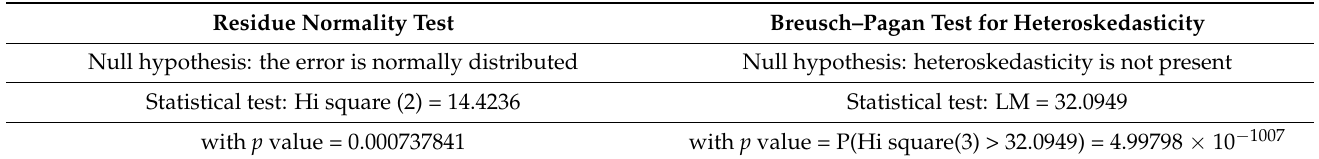
Table 3. Statistical tests to validate the European volatility matrix